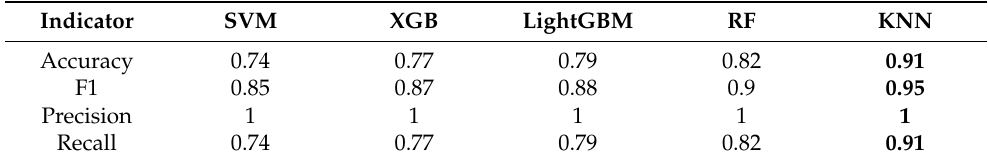
Table 4. Low Risk Predictive Model Evaluation